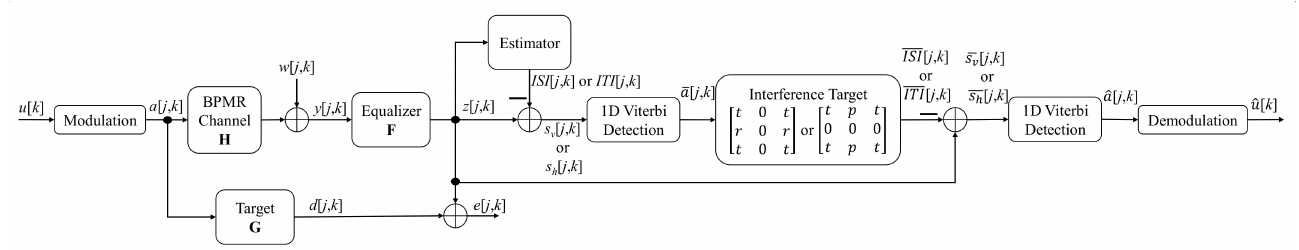
Figure 2. Proposed detection